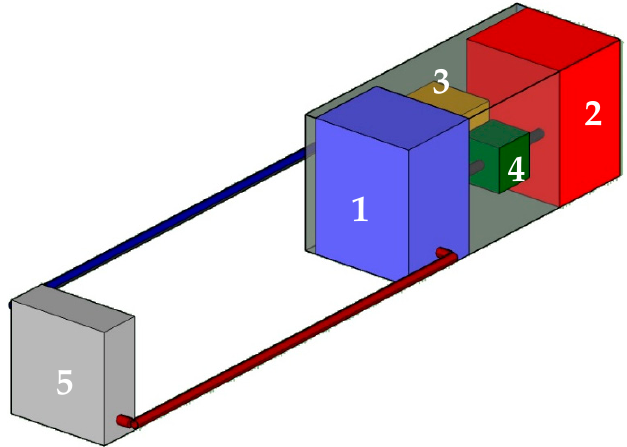
Figure 11. The layout of the ORC plant with the radiator. 1. Condenser; 2. Evaporator; 3. Expander; 4. Pump; 5. Vehicle radiator .